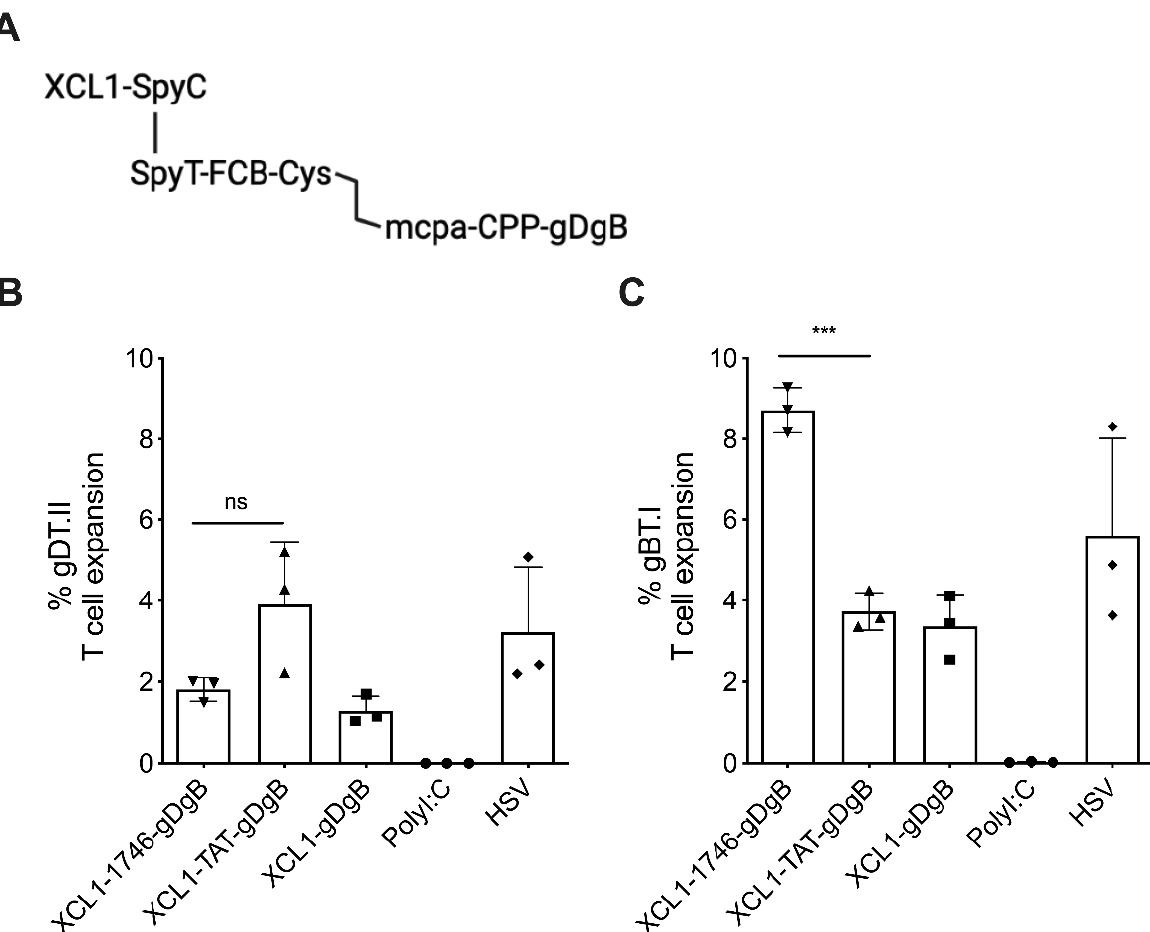
Figure 2. Addition of furin/cathepsin B cleavage motifs to vaccine constructs enhances gBT.I CD8 + T cell expansion following prime-boost vaccination with XCL1-targeted 1746-vaccine: ( A ) The peptide vaccine construct comprises an XCR1 targeting unit (XCL1-SpyC) linked to a vaccine unit (SpyT-FCB-Cys-Cys-CPP-gBgD) containing furin/cathepsin B cleavage motifs (FCB) to facilitate uncoupling of the vaccine within the endosome to allow for endosomal escape. Treatment schedule; mice received adoptive transfer of 1 × 10 5 gBT.I and 1 × 10 4 gDT.II T cells prior to subcutaneous prime and boost vaccinations with 2 nM of vaccine constructs plus 50 ug Poly(I:C). ( B ) gDT.II (CD4 + ) and ( C ) gBT.I (CD8 + ) T cell expansion was measured as percentage of the total CD4 + or CD8 + pool 7 days after the boost vaccination. Data are shown for the different vaccine constructs (XCL1-1746-gDgB, XCL1-TAT-gDgB or XCL1-gDgB) plus Poly(I:C) alone as negative control. HSV infection (natively expressing vaccine epitopes) was used as a positive control. Data are from a single experiment, representative of two similar experiments, and n = 3 three mice per group, displayed as mean +/ − SEM. *** p < 0.001, ns = not significant.